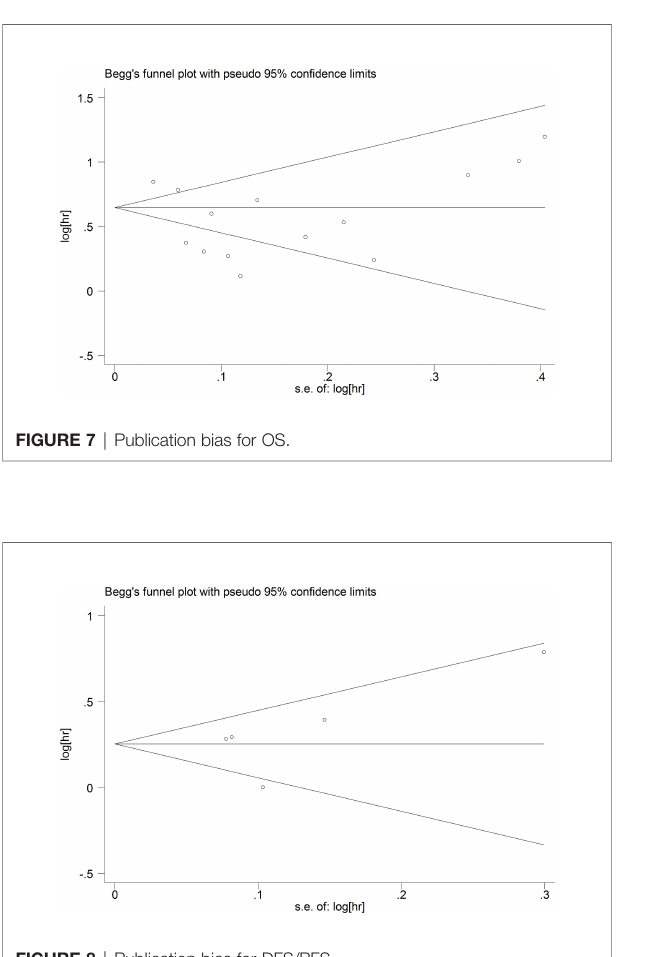
FIGURE 8 | Publication bias for